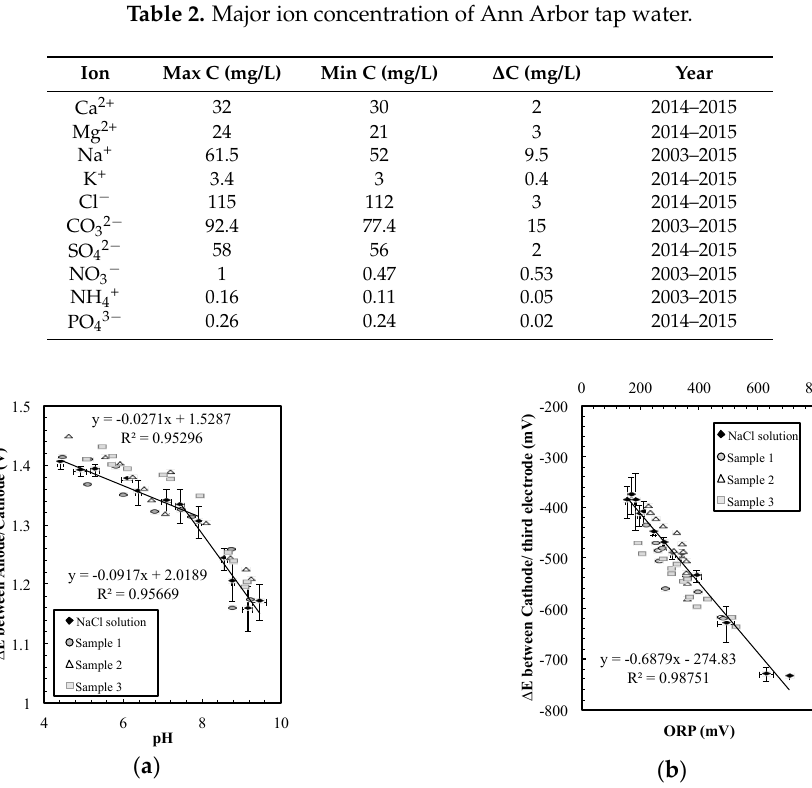
Table 1. Ions in the test samples (mg/L).